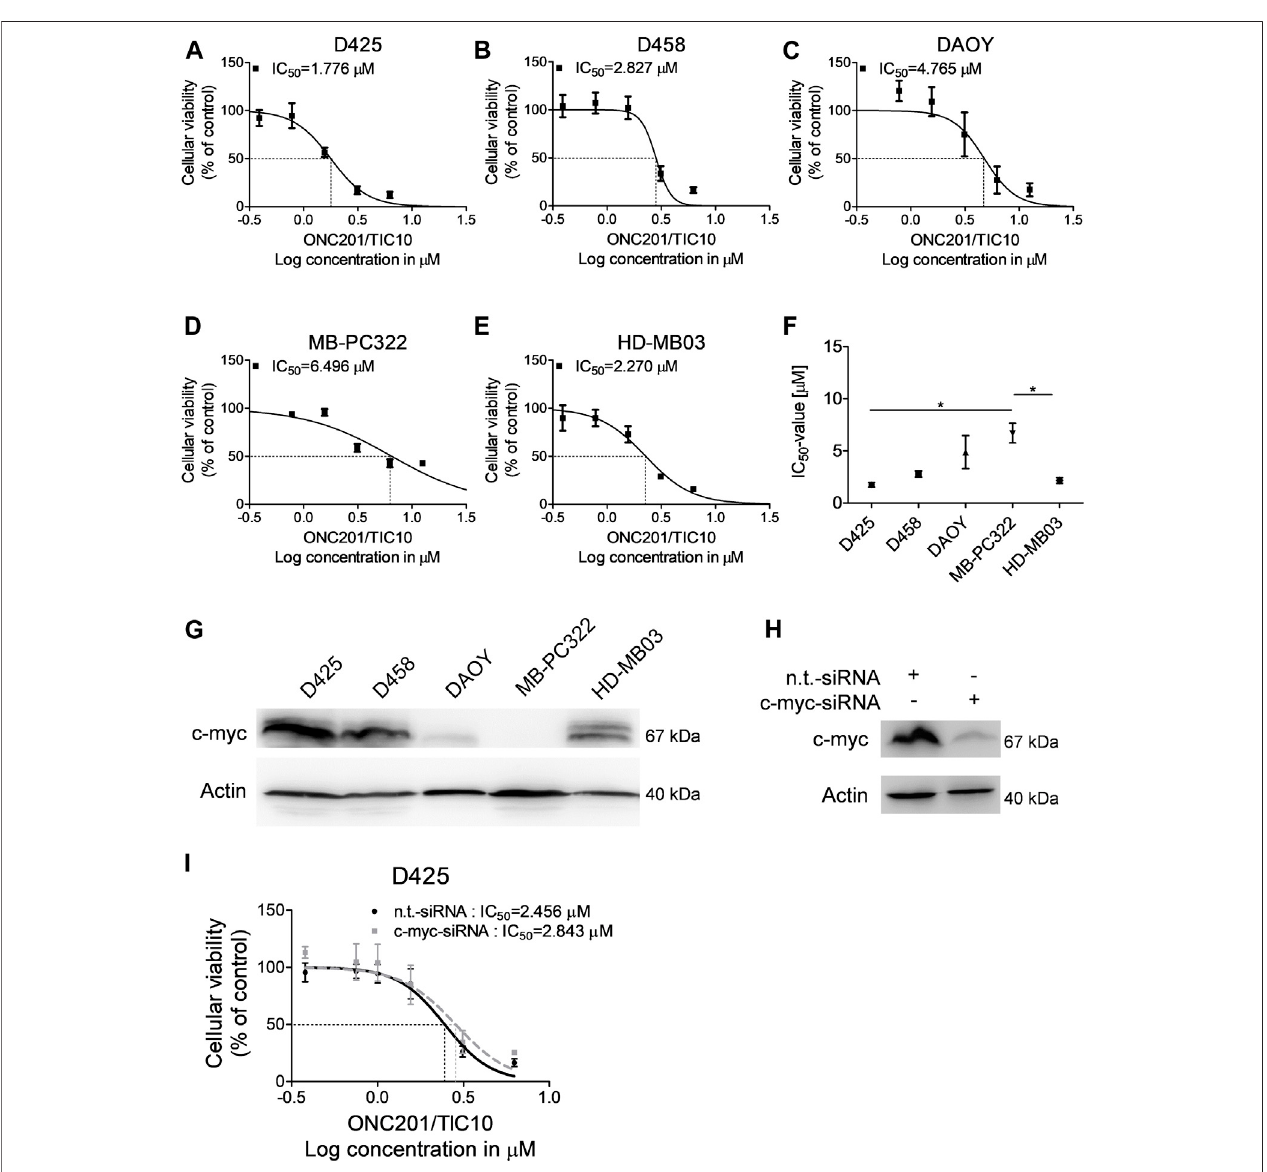
FIGURE 1 | ONC201/TIC10 has a dose-dependent anti-proliferative effect on medulloblastoma cells. (A – E) , D425, D458, DAOY, MB-PC322 and HD-MB03 cells were treated with solvent or increasing concentrations of ONC201/TIC10 under serum starvation (1.5%FBS). Non-linear regression was performed and IC 50 - values were calculated. Data are presented as mean and SEM of three independent experiments. (F) , Quantitative representation of the IC 50 -values for indicated cells treated as described for (A – E) . Mean, SEM and n (cid:1) 3. * p < 0.05. (G) , Whole cell extracts of D425, D458, DAOY, MD-PC322 and HD-MB03 cells were collected and subjected to Western blot analysis for c-myc and Actin. (H) , D425 cells were transfected with non-targeting (n.t.)-siRNA or c-myc-siRNA. Cell lysates were collected and Western blot analysis for c-myc and Actin was performed. (I) , D425 cells were treated as described for H prior to treatment with solvent or increasing concentrations of ONC201/TIC10. Non-linear regression was performed and IC 50 -values were calculated. Data are presented as mean and SD of three independent experiments.